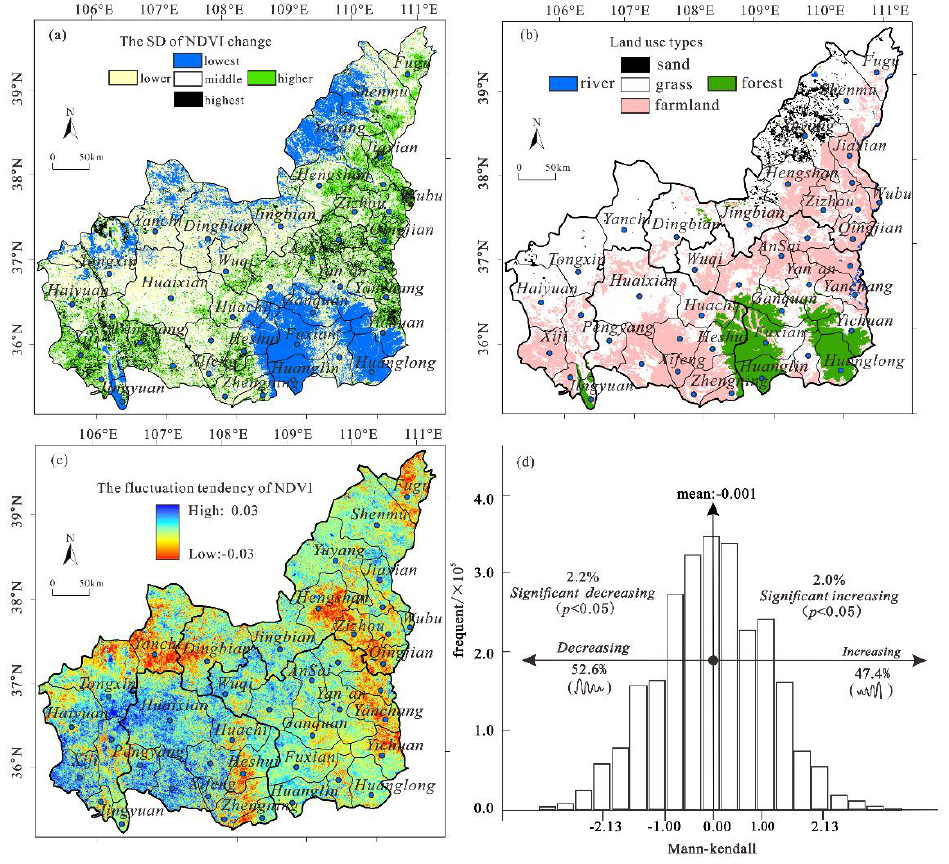
Figure 4. The stability of NDVI changes in the Shaanxi-Gansu-Ningxia Region from 2000 to 2014. ( a ) Standard deviation of NDVI changes from 2000 to 2014; ( b ) Land use types in the Shaanxi-Gansu-Ningxia region; ( c ) The fluctuation tendency of NDVI from 2000 to 2014; ( d ) The distribution of trends in NDVI variation in the region from 2000 to